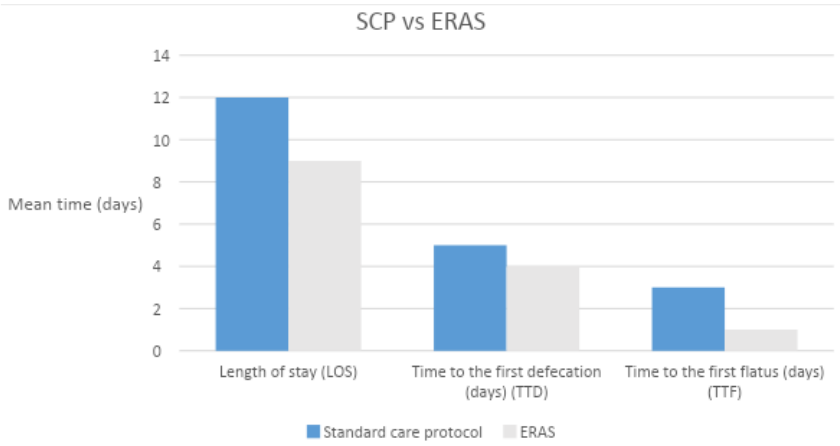
Figure 1. The standard care protocol vs. the ERAS protocol: LOS, TTD, TTF.